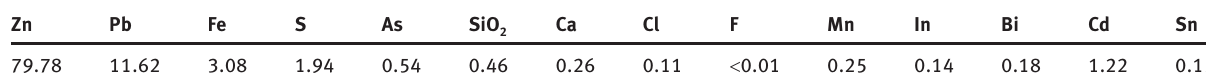
Table 1: Chemical compositions of zinc oxide dust sample (mass fraction, %) Zn Pb Fe